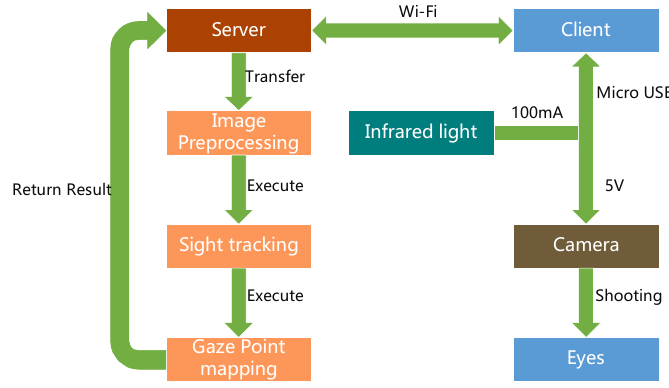
Figure 8. System architecture diagram [10].